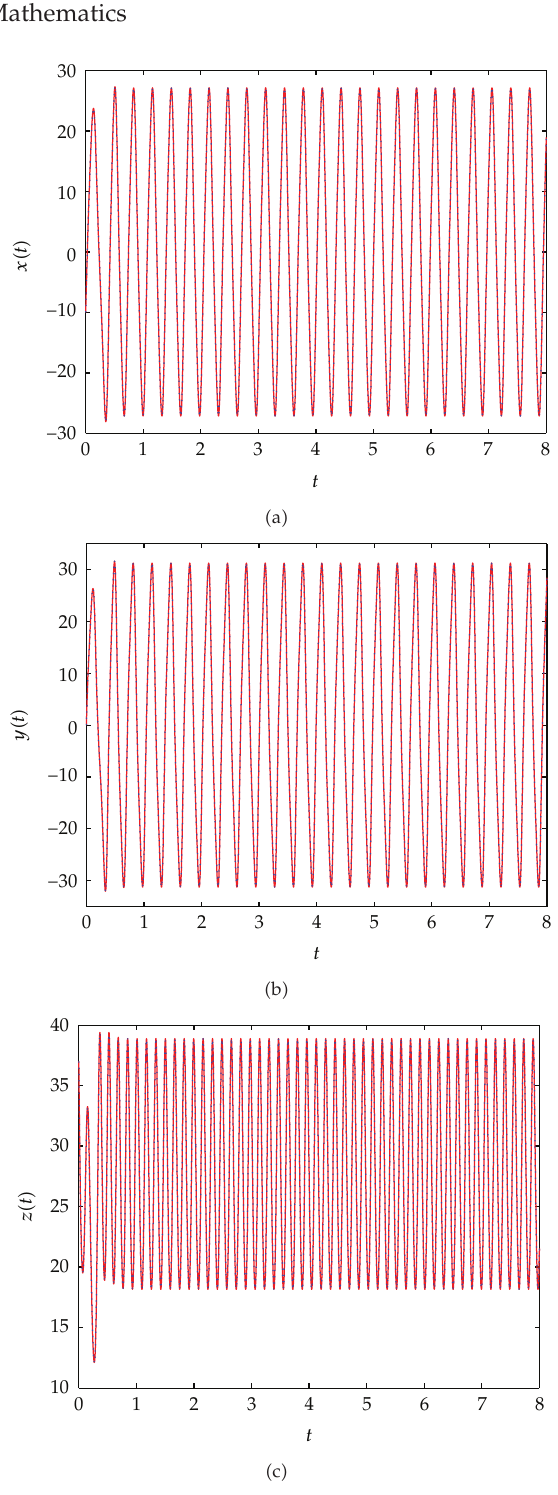
Figure 1: Time series PSLM (cid:2) solid line (cid:3) and ode 45 (cid:2) dots (cid:3) results for nonchaotic case with parameters a (cid:7) 35, b (cid:7) 12, and c (cid:7)